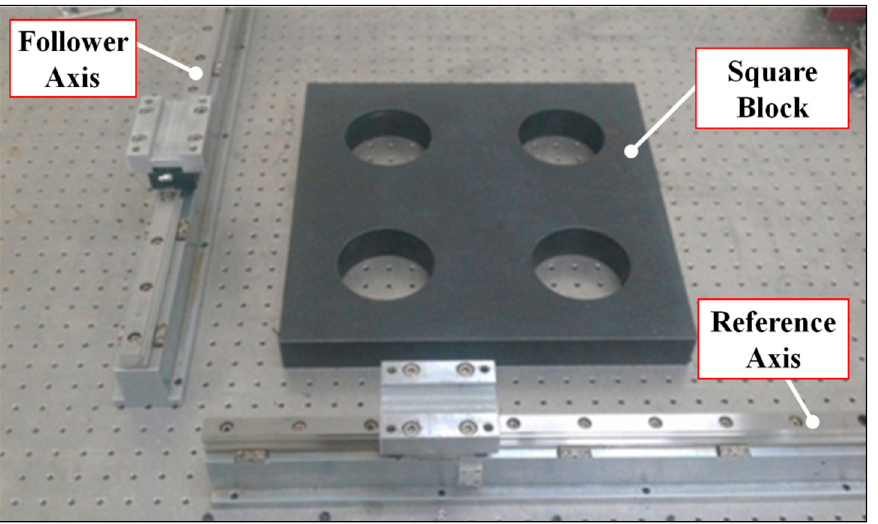
Figure 16. Verification setup of perpendicularity measurement using a square block.